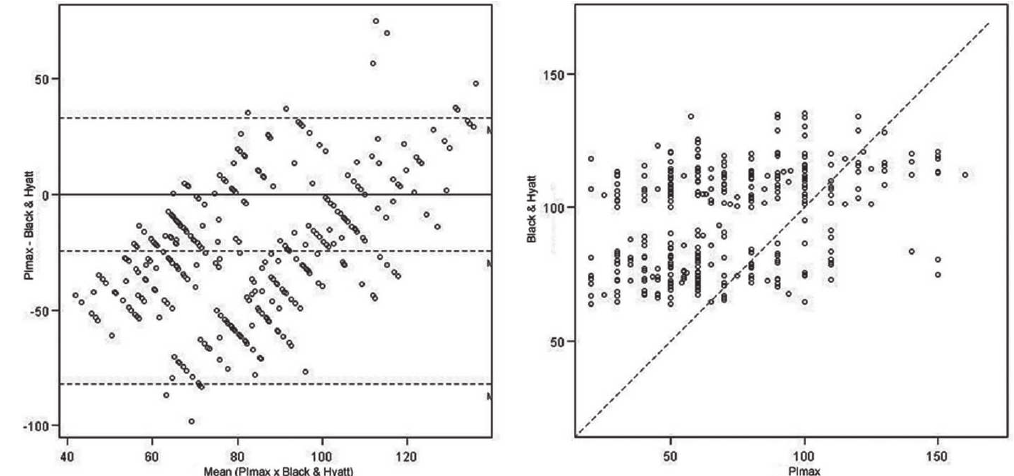
Fig. 1 - Bland-Altman plot and Lin's coefficient of maximal inspiratory pressure (MIP) values predicted by the formula of Black and Hyatt. Confidence interval 95% (0.16 – 0.29); Lin coefficient